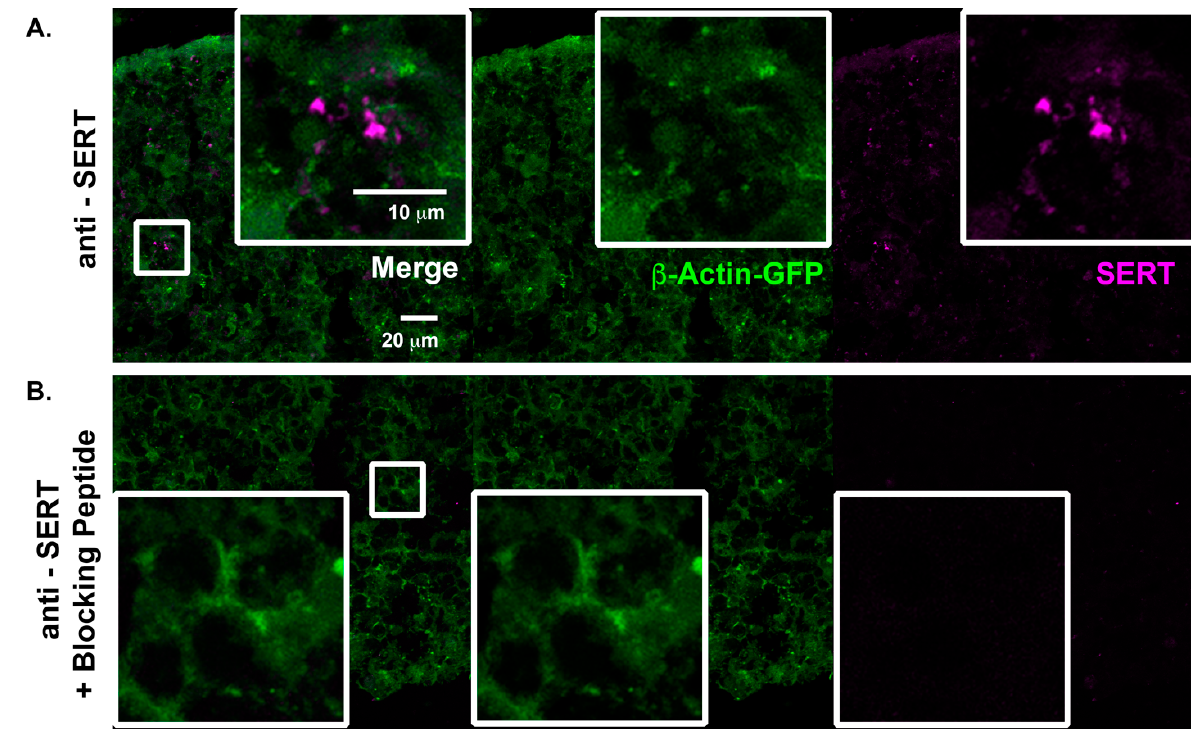
Figure 2. Human cortical spheroids express the serotonin transporter SERT. ( A ) 3-month-old untreated cortical spheroids were immunostained with the SERT antibody or ( B ) the SERT antibody together with the blocking peptide to evaluate antibody specificity. Endogenous β -actin-GFP (green) and immunostained SERT (magenta) were imaged with confocal microscopy under identical conditions. Scale bar = 10, 20 μ m.